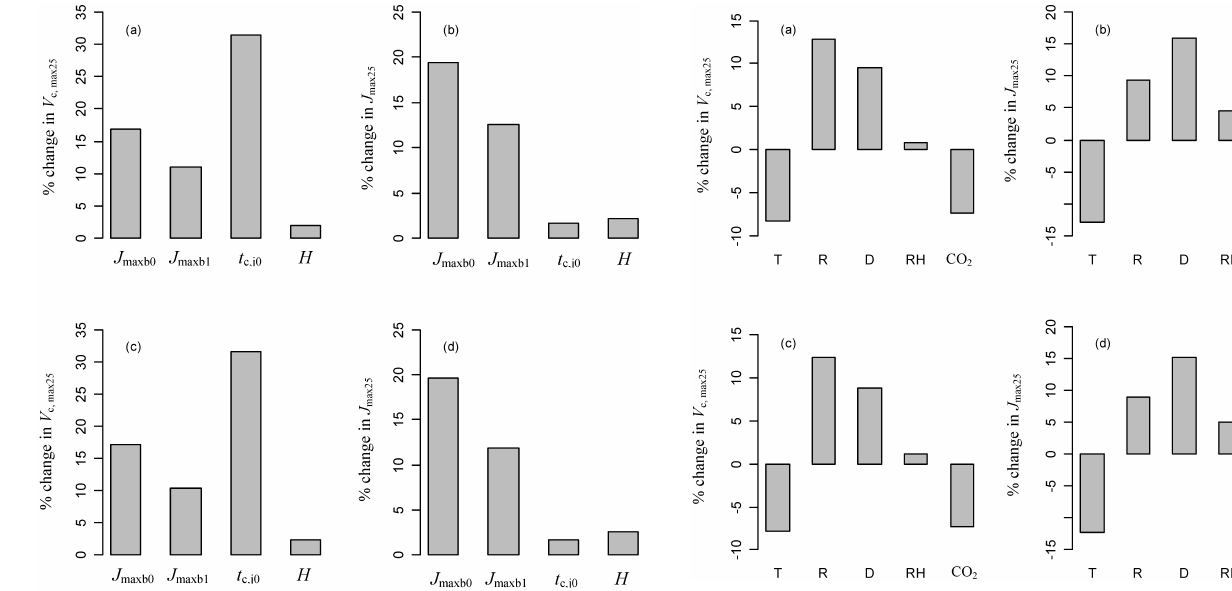
Figure 2. Sensitivities of V c , max25 (µmolCO 2 m − 2 s − 1 ) ( a , TRF1; c , TRF2) and J max25 (µmolelectronm − 2 s − 1 ) ( b , TRF1; d , TRF2) to changes in model parameters. Each parameter ( J maxb0 , J maxb1 , t c ,j 0 , and H) is varied one at a time by ± 15% of its fitted value. The values of environmental variables are held fixed at their mean values with day length = 14h, daytime radiation = 182Wm − 2 , tempera- ture = 14 ◦ C, relative humidity = 0.6 (unitless) and CO 2 concentra- tion = 393ppm. V c,max25 and J max25 values are first obtained at changed parameter values and the percentage changes in V c,max25 and J max25 are then calculated relative to the baseline values of V c,max25 and J max25 predicted based the default parameter values. Positive values indicate that the increase in a specific model param- eter leads to larger values of V c,max25 or J max25 , while negative values indicate that the increase in a specific model parameter leads to smaller values of V c,max25 or J max25 .